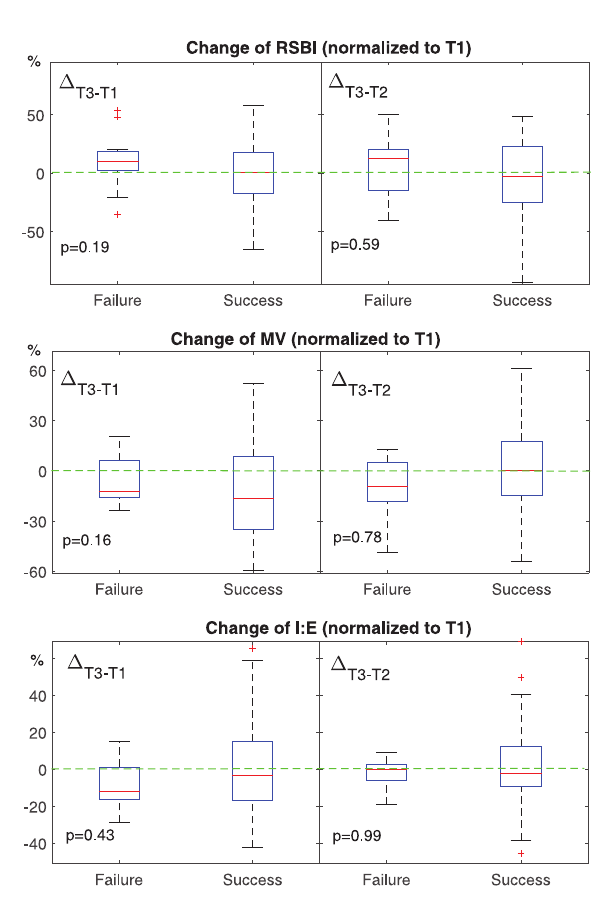
FIGURE 3 | Change of EIT-based parameters for spontaneous breathing at different time points. T1, before HFNC; T2, 30min after HFNC started; T3, 1h after HFNC started. All values were normalized to that at T1. The boxes mark the quartiles with median marked red, while the whiskers extend from the box out to the most extreme data value within 1.5* the interquartile range of the sample. The red crosses are outliers. Green dashed lines marked the value of 0. RSBI, rapid shallow breathing index. Higher than 0 means the subject is breathing more rapidly or shallowly. MV, minute volume. Lower than 0 means the minute volume becomes less at T3. I:E, inspiration to the expiration time. Lower than 0 means the inspiration time is getting